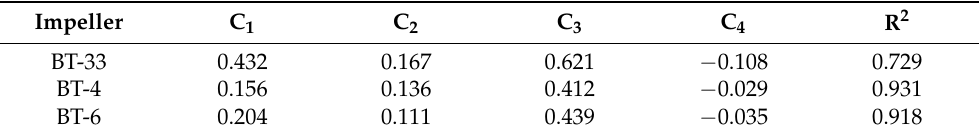
Table 2. Constants in Equation